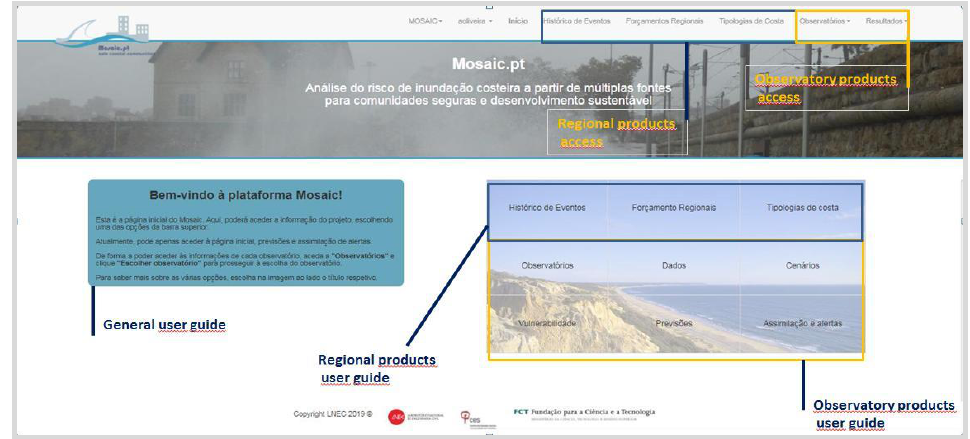
Figure 4. Main dashboard and help center.